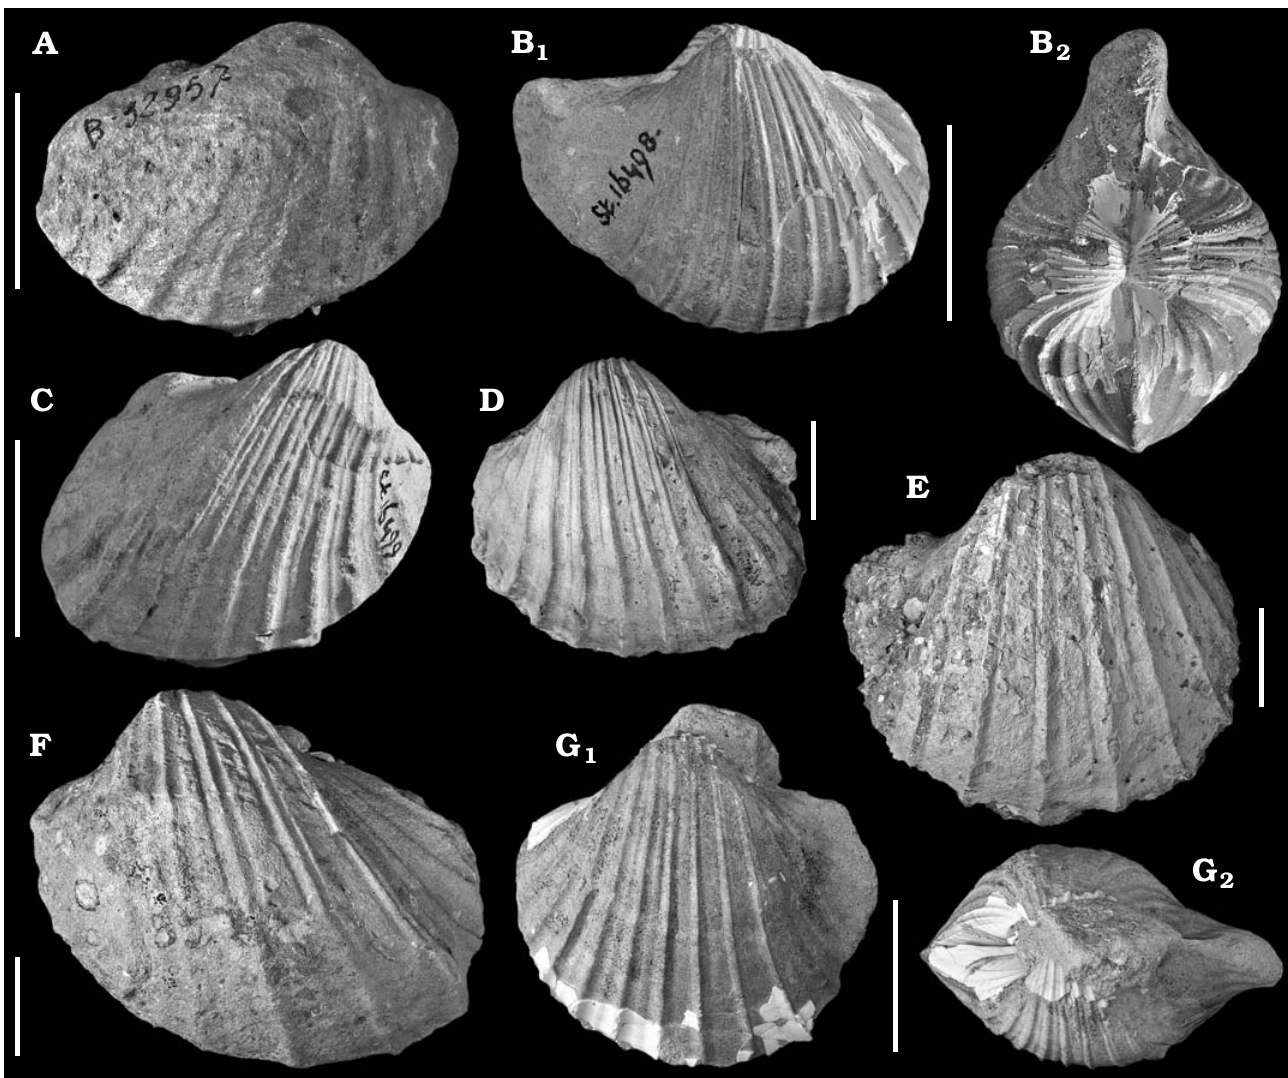
Fig. 10. Cardiid bivalve Procardium spp., internal moulds, from Serravallian? (Miocene) of Turkey. A . Syntype of Cardium subhians Fischer, 1866, MNHN.F.B32957, between Ermenek and Bostanesou (photo Peter Massicard, http://coldb.mnhn.fr/catalognumber/mnhn/f/b32957). B . Holotype of Cardium cilicianum Toula, 1901, RGM.16498, Karaman Basin, exact locality unknown; external (B 1 ) and umbonal (B 2 ) views. C . Cardium subhians Fischer sensu Toula, 1901, RGM.16499 (Claessens collection), exact locality unknown, Karaman Basin. D – G . Procardium sp. D . RGM.1309264